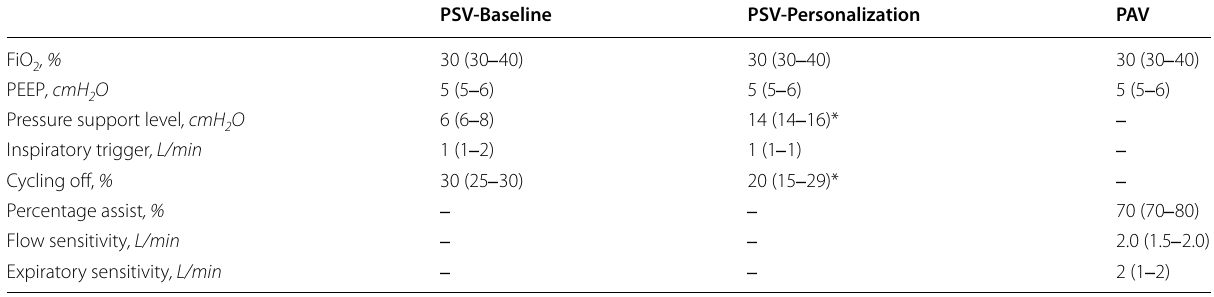
Table 2 Ventilator settings at baseline (PSV‑Baseline), after personalization of ventilator settings (PSV‑Personalization) and with proportional assist ventilation (PAV)